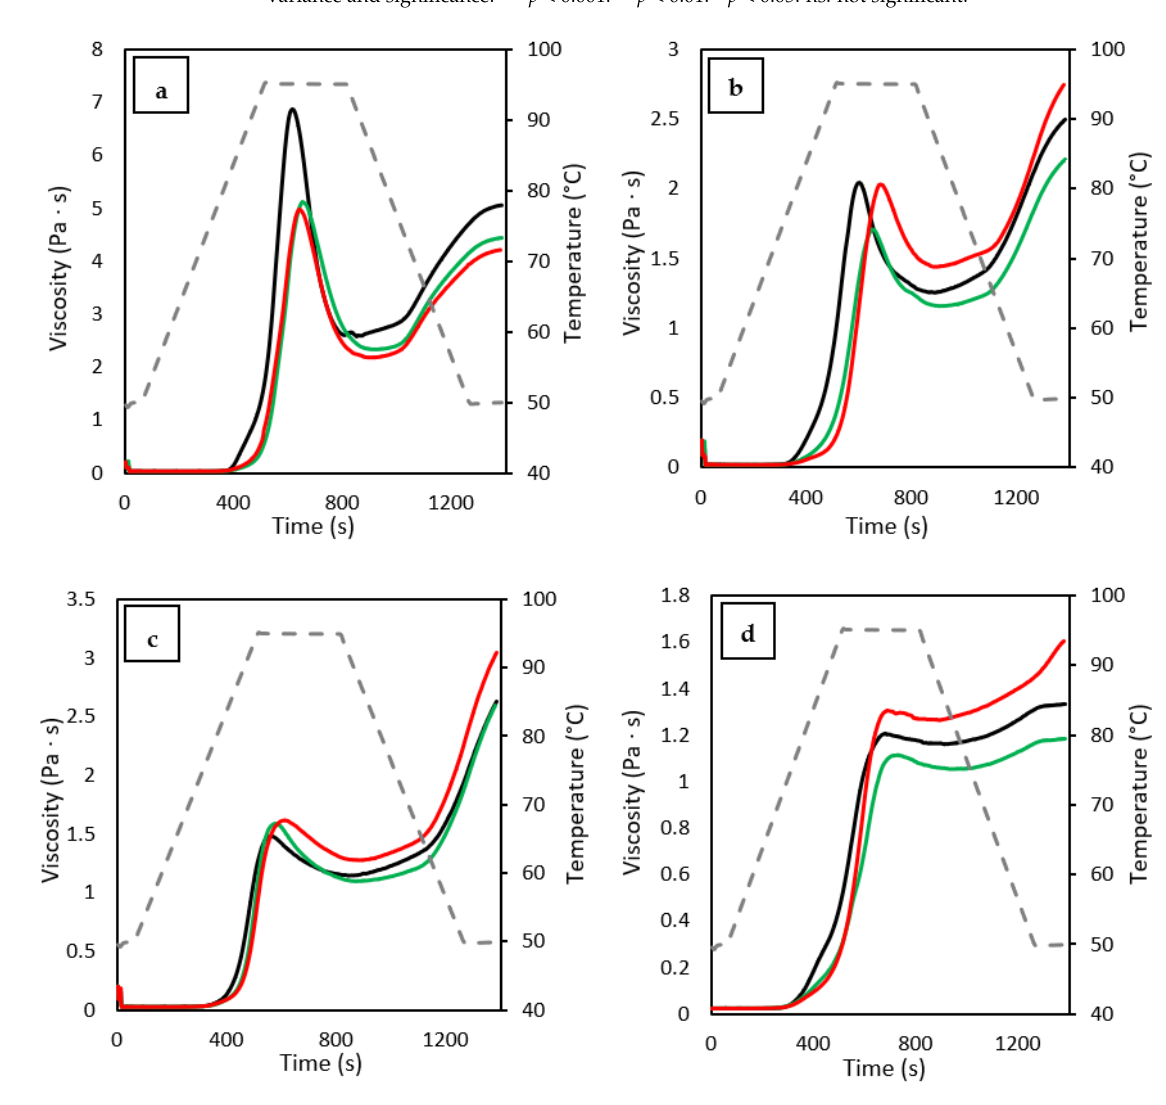
Figure 2. Viscometric profiles of the studied ( a ) rice, ( b ) tef, ( c ) corn and ( d ) quinoa flours. Black lines correspond to native samples, green lines to freeze-dried samples, red lines to centrifuged samples and grey discontinuous lines to the temperature of the assay.